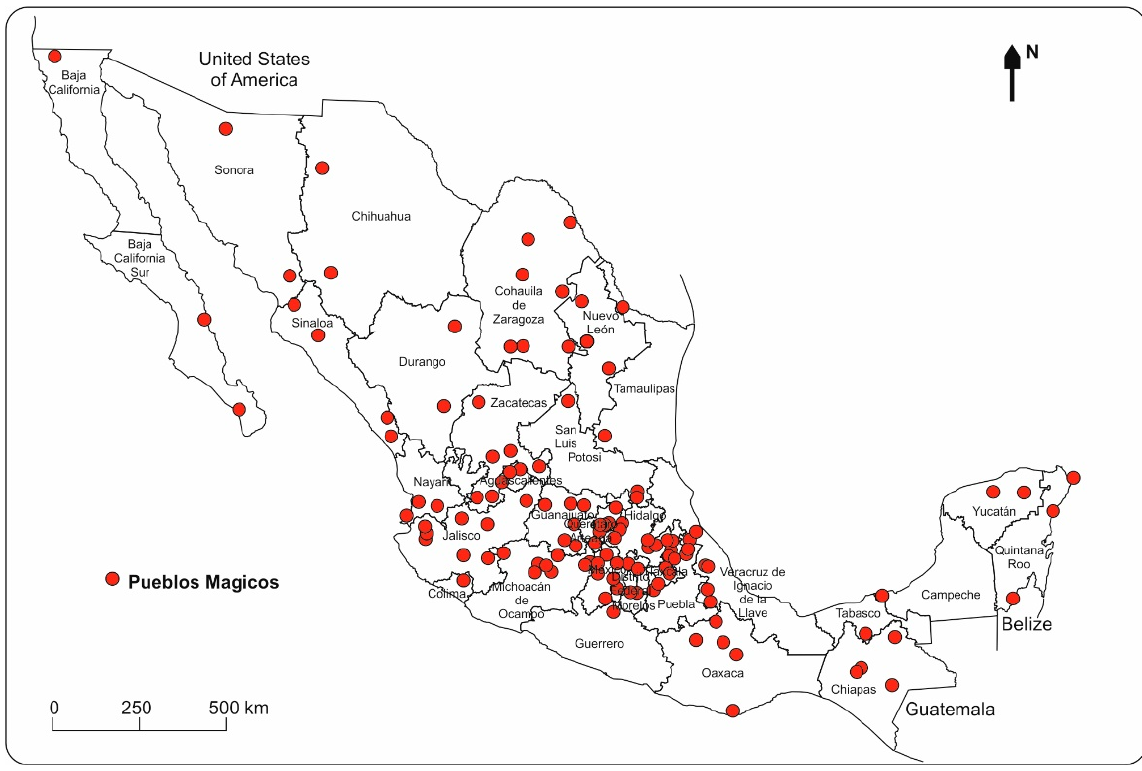
Figure 1. Pueblos Mágicos in Mexico. Source: Authors’ own work, based on [5]. Figure 1. Pueblos M á gicos in Mexico. Source: Authors’ own work, based on [5]. The PPM has been examined by researchers in a variety of ways [3]. Most liter- ature sources analyze this program in terms of its overall functioning within selected towns [6–11]. A more holistic approach concerned with its implementation and its func- tioning is presented in works by F. Madrid [4,12] and N ú ñez Camarena and Ettinger Mc Enulty